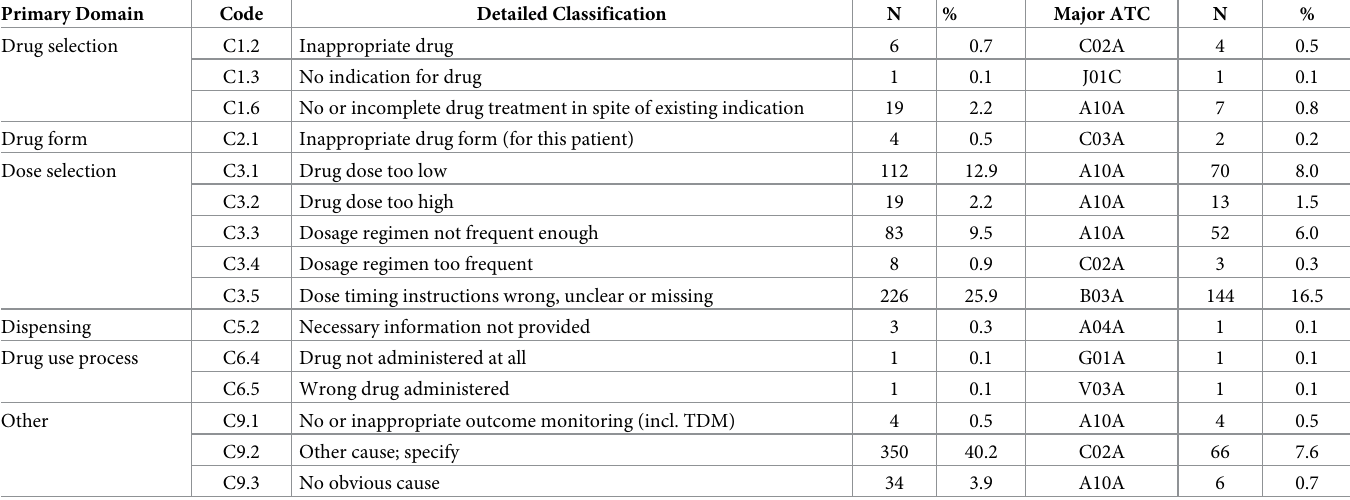
Table 3. Causes of Drug-Related Problems (DRPs) (n = 873) according to the Pharmaceutical Care Network Europe (PCNE) V9.00 classification and main sub- groups involved. Primary